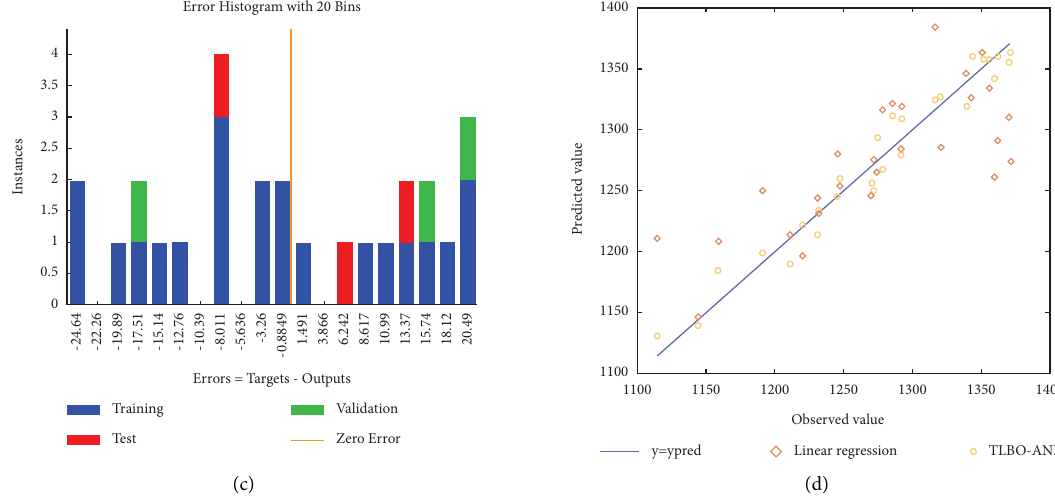
Figure 15: Modeling for stroke by ANN-combined TLBO method: (a) training, (b) performance, (c) error, (d) predicted vs measured value.